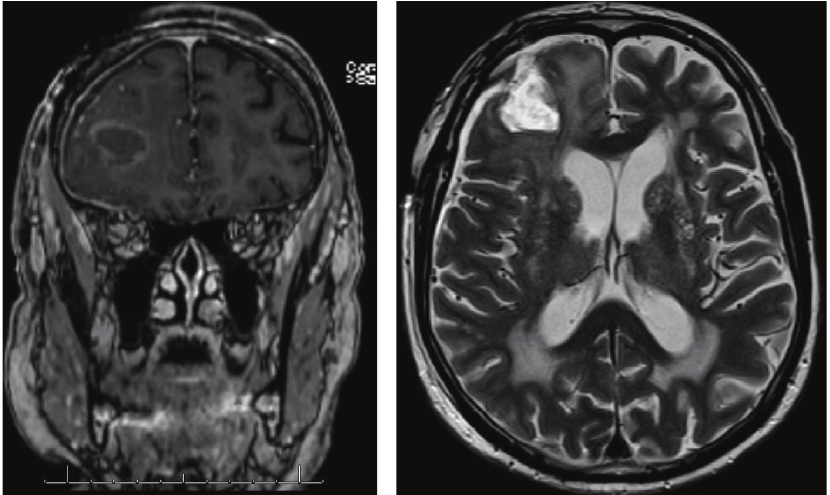
Figure 4: Cerebral MRI: right frontal lesion.